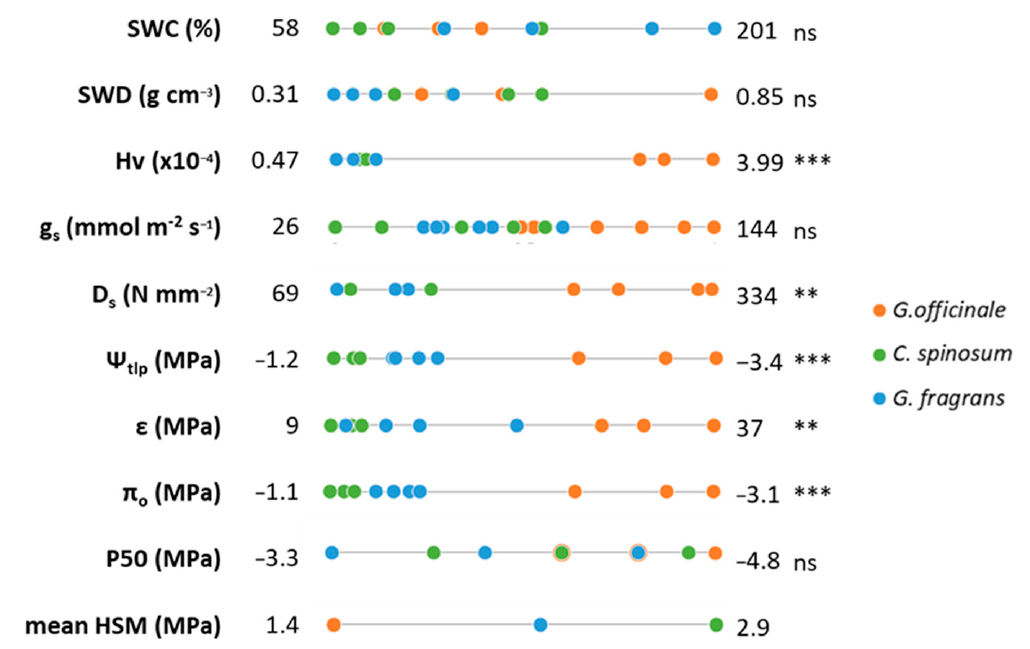
Figure 7. Plant traits with respect to water relations: wood and stomatal traits, pressure–volume parameters ( π o: osmotic potential at full turgor, Ψ TLP : water potential at turgor loss point and ε : elasticity modulus) and hydraulic traits (P 50 and mean HSM). For each trait, significant differences between species are indicated (* p < 0.05, ** p < 0.01, *** p < 0.001 ns: non significant). See Table 1 for acronyms.